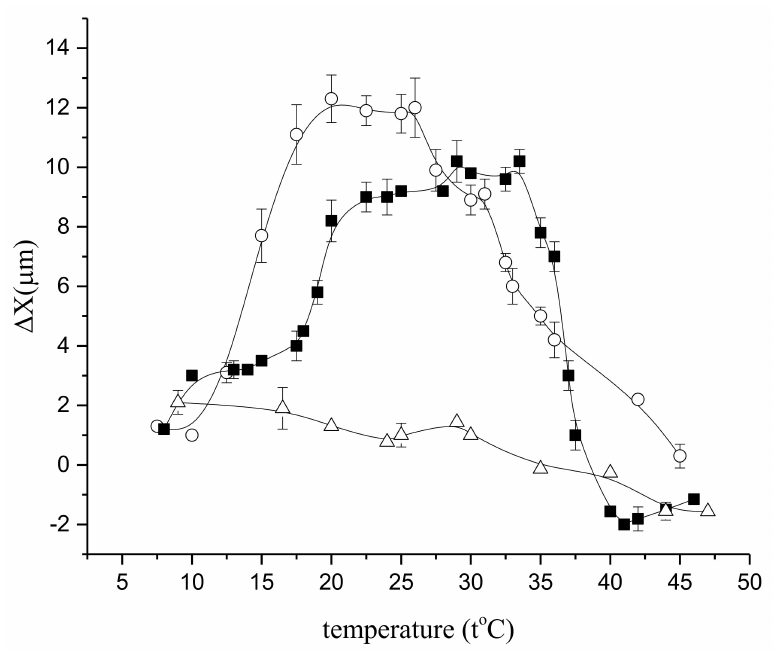
Figure 17. Temperature dependence of ∆ x in the control ( (cid:4) ) and under the effect of gadolinium ( BDM ( ∆ )